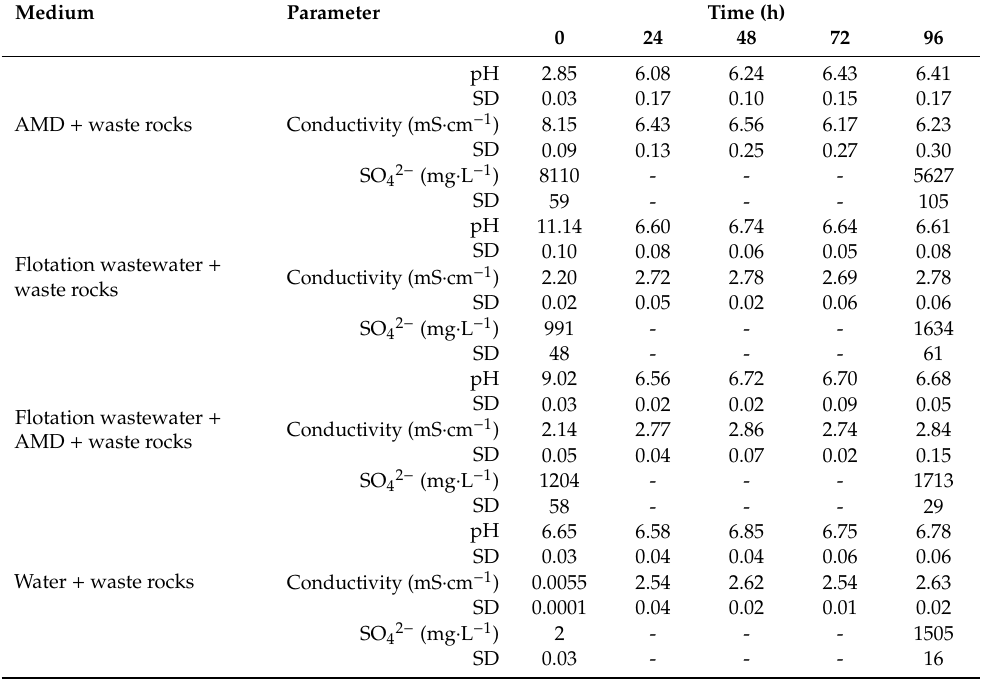
Table 6. Neutralization of four selected liquids by long-term stored waste rocks 20 g of the waste rocks was mixed with 20 mL of the